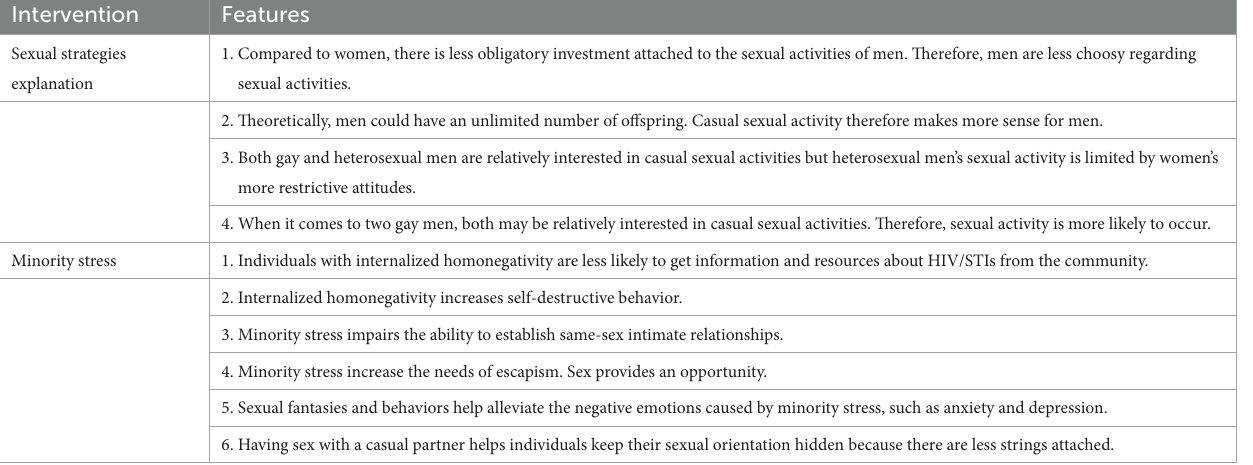
TABLE 4 Main features of both